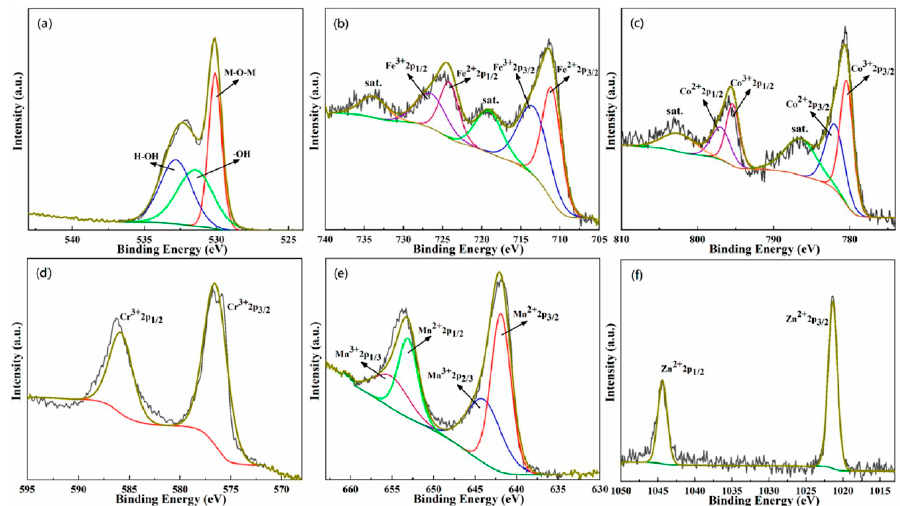
Figure 4. X-ray photoelectron spectroscopy (XPS) patterns of (FeCoCrMnZn) 3 O 4 powders: ( a ) O 1 s , ( b ) Fe 2 p , ( c ) Co 2 p , ( d ) Cr 2 p , ( e ) Mn 2 p , and ( f ) Zn 2 p .